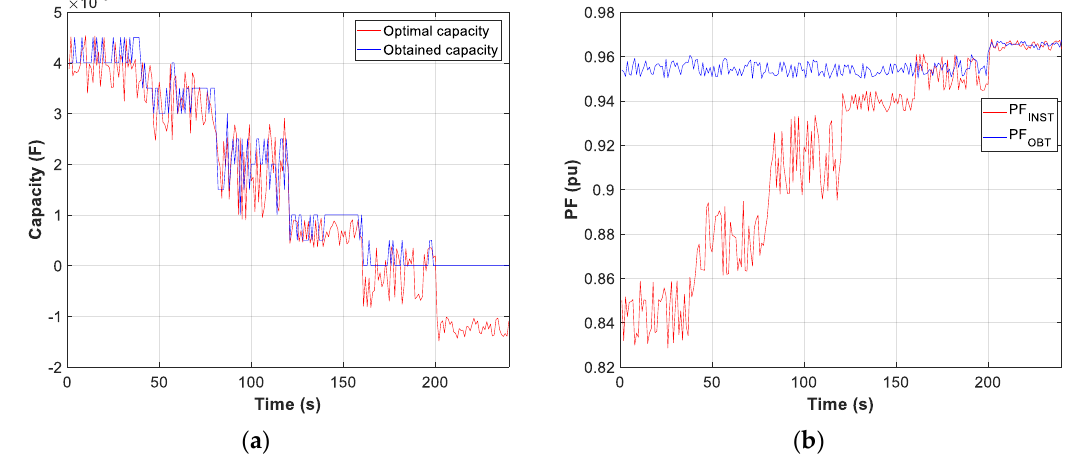
Figure 11. One-phase motor comparison: ( a ) Obtained vs optimal capacity; ( b ) PF INST vs PF OBT .